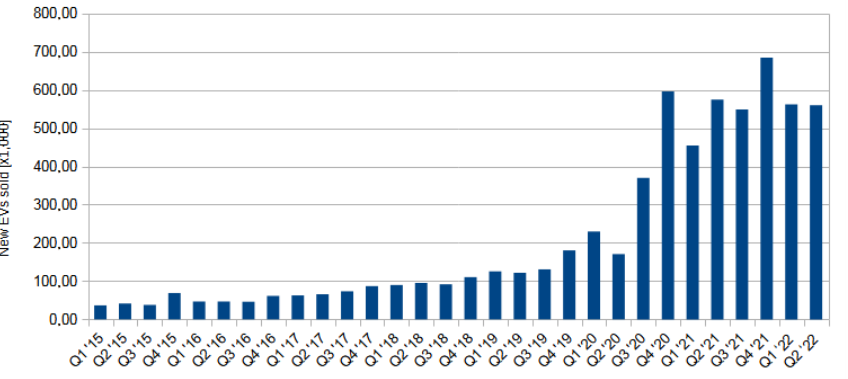
Figure 1. Quarterly sales volumes of EVs in the EU from Q1 2014 to Q2 2022